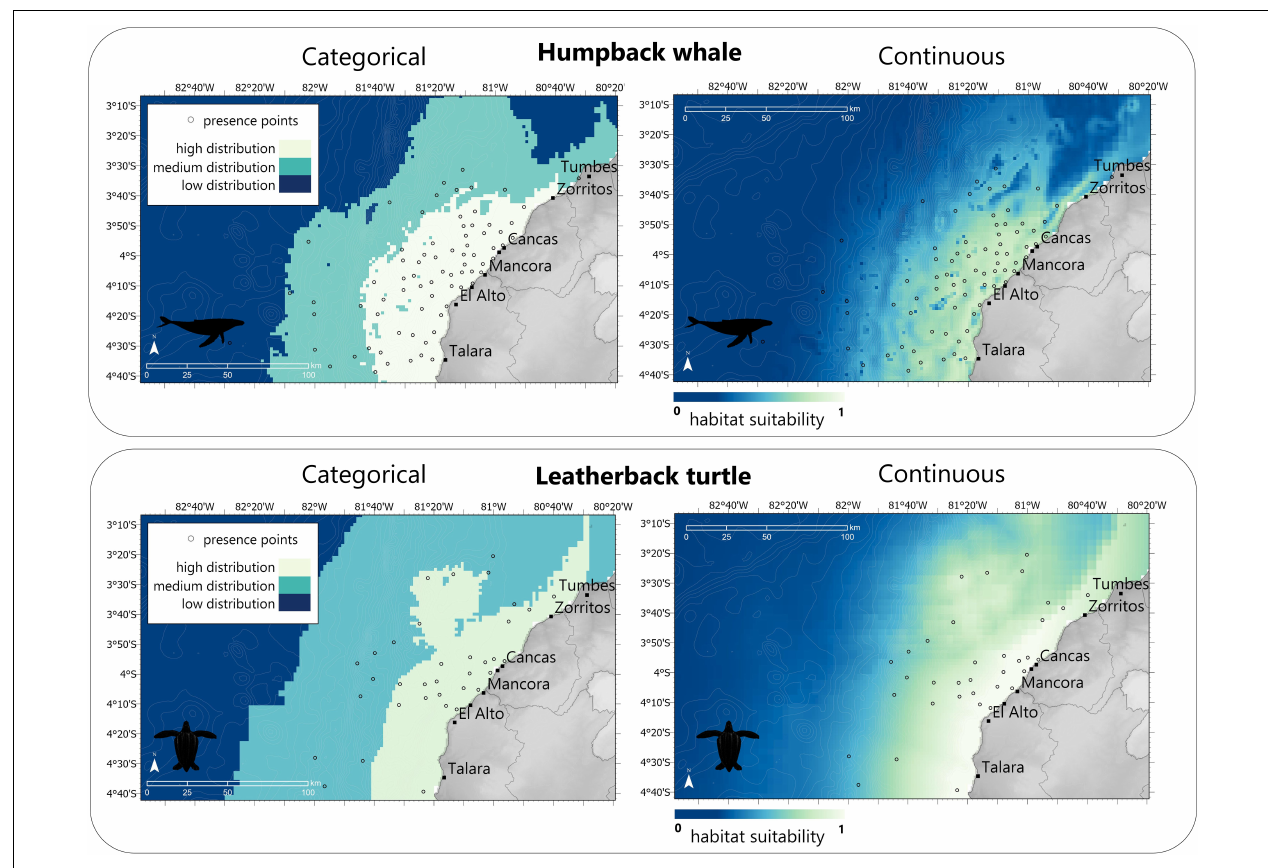
FIGURE 7 | Final Maxent model outputs for humpback whales and leatherback turtles were built based on interview responses from PGIS mapping. The top row are the habitat suitability predictions as continuous data with values ranging between 0 and 1. The second row of maps are discretized into three classification levels using the Relative Occurrence Rate (ROR). The low category ranges from 0 to 10% of the maximum ROR. The medium category ranges from 10% of the maximum ROR to 50% of the maximum ROR, and the high category ranges from 50% of the maximum ROR to the maximum